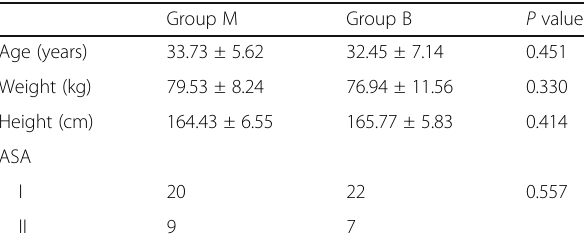
Table 1 Demographic patients ’ characteristics and ASA status